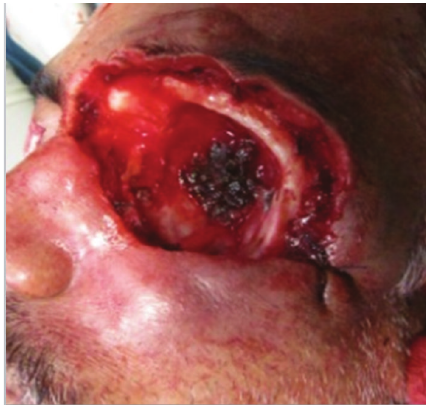
Figure 5: Postexcision.